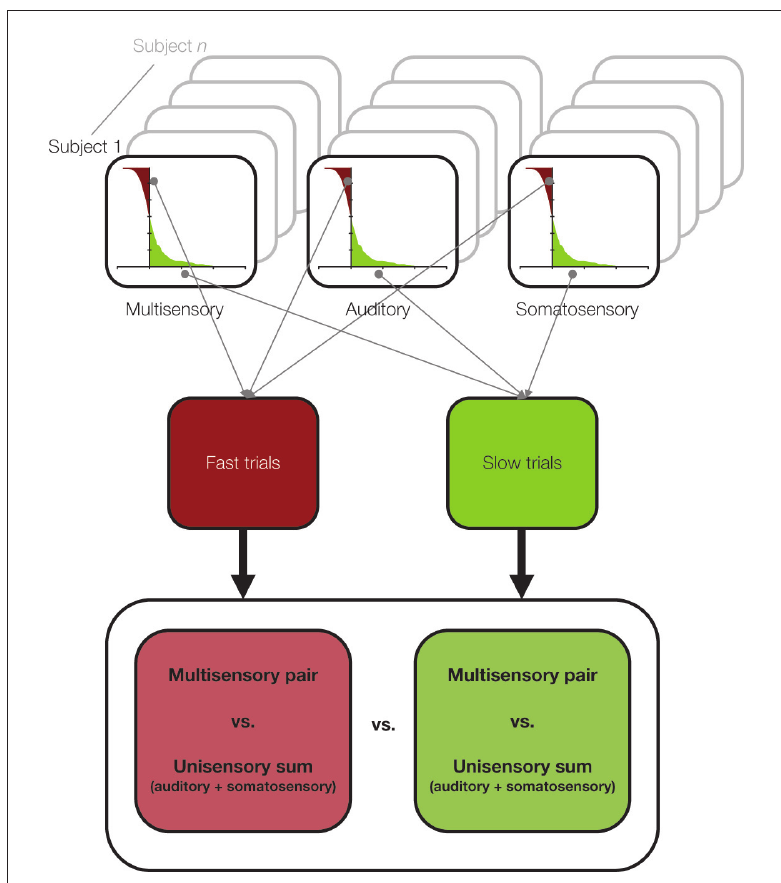
Figure 2 | A schematic of the median split analysis approach applied in Sperdin et al. (2009). For each subject and stimulus condition, trials were sorted according to RT speed. Those with RTs faster than the median were considered “fast” and those slower than the median were considered “slow”. Event-related potentials were likewise separately averaged according to RT speed, and compared using the linear model schematized in Figure 1 . Data were analyzed in using a multi-factorial within subjects